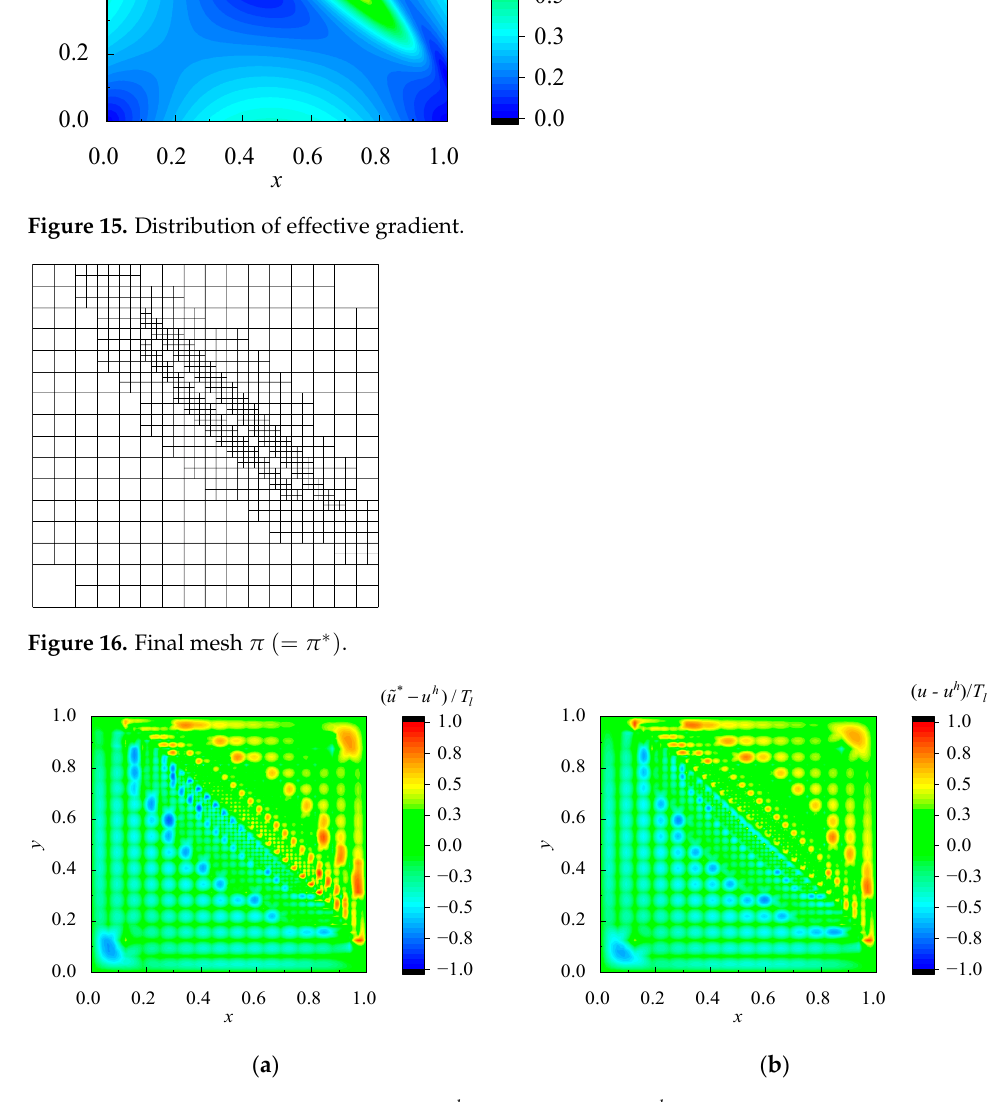
Figure 15. Distribution of effective gradient.